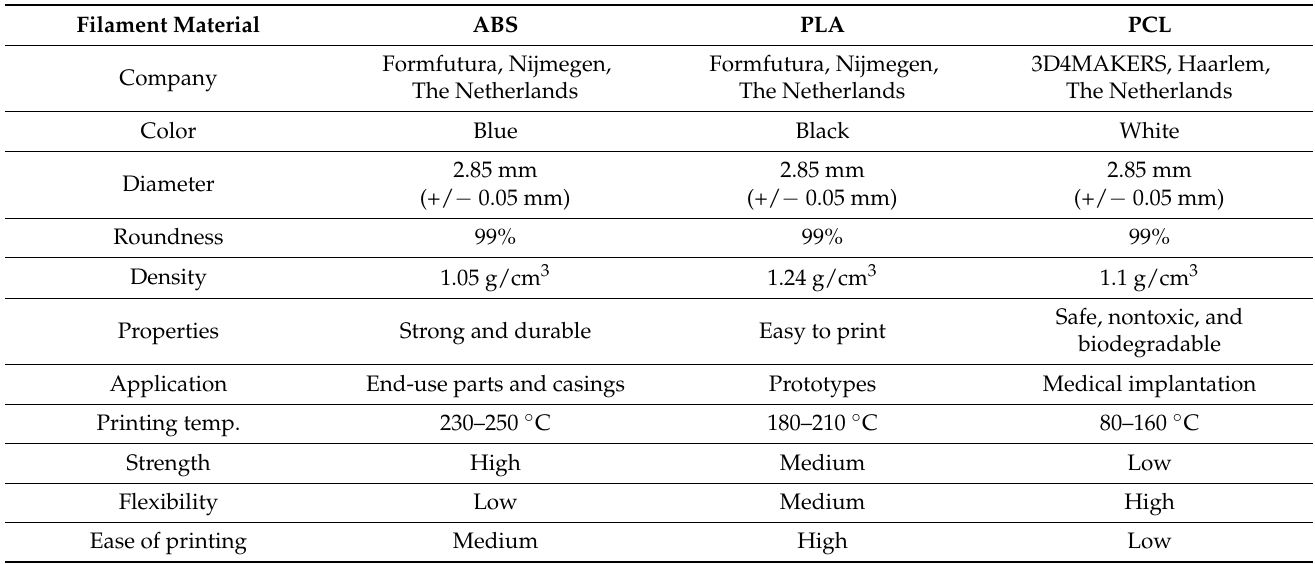
Table 5. Overview of the rheological features potential application of the thermoplastic